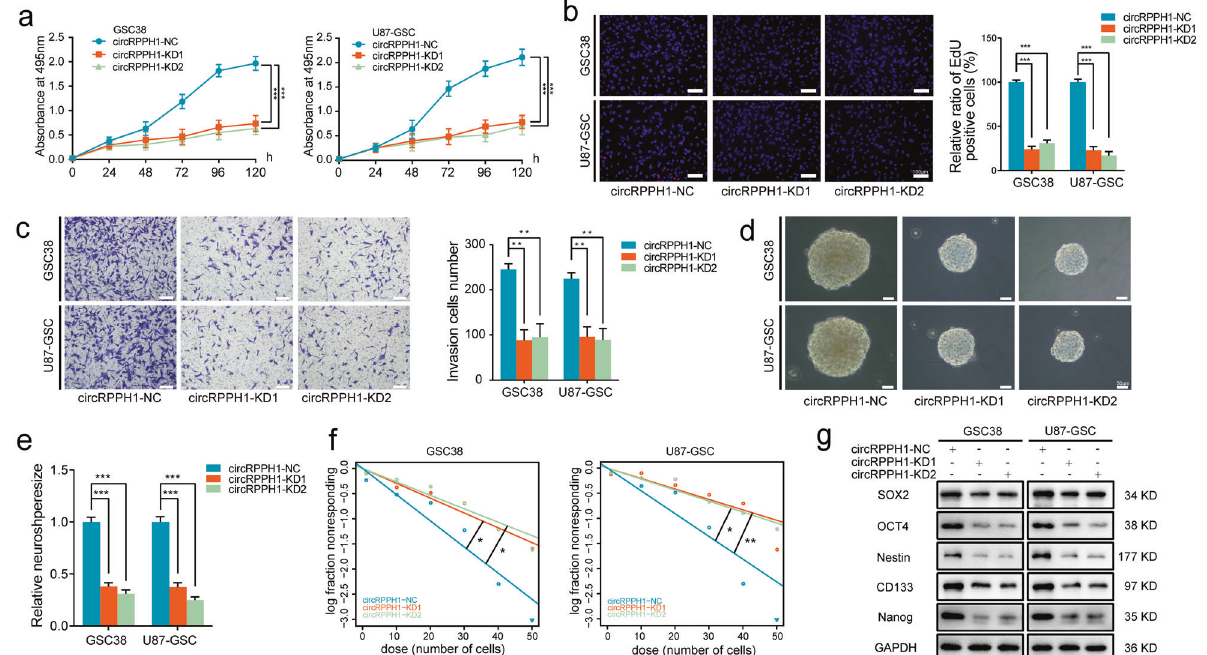
Fig. 2 Knockdown of circRPPH1 suppressed the proliferation, invasion, self-renewal, and the expression of stemness in GSCs. a MTS assays showed that the cell viability of GSC38 and U87-GSC decreased after circRPPH1 knockdown. (GSC38, p < 0.001; U87-GSC, p < 0.001; Student ’ s t-test). b EdU assays showed the proliferation of GSC38 and U87-GSC decreased after circRPPH1 knockdown. Scale bar = 100 μ m. (GSC38, p < 0.001; U87-GSC, p < 0.001; Student ’ s t-test). c Transwell assays showed the invasion abilities of GSC38 and U87-GSC were weakened under circRPPH1 knockdown. Scale bar = 100 μ m. (GSC38, p < 0.01; U87-GSC, p < 0.01; Student ’ s t-test). d , e Neurospheres formation assays showed a decreased sphere size after circRPPH1 knockdown in GSC38 and U87-GSC. Scale bar = 50 μ m. (GSC38, p < 0.001; U87-GSC, p < 0.001; Student ’ s t-test). f Extreme limiting dilution analysis showed the decreased stem cell enrichment under circRPPH1 knockdown. (GSC38, kd1: p = 0.0362, kd2: p = 0.0152; U87-GSC, kd1: p = 0.0066, kd2: p = 0.0104; ELDA analysis; circles represent corresponding points, triangles